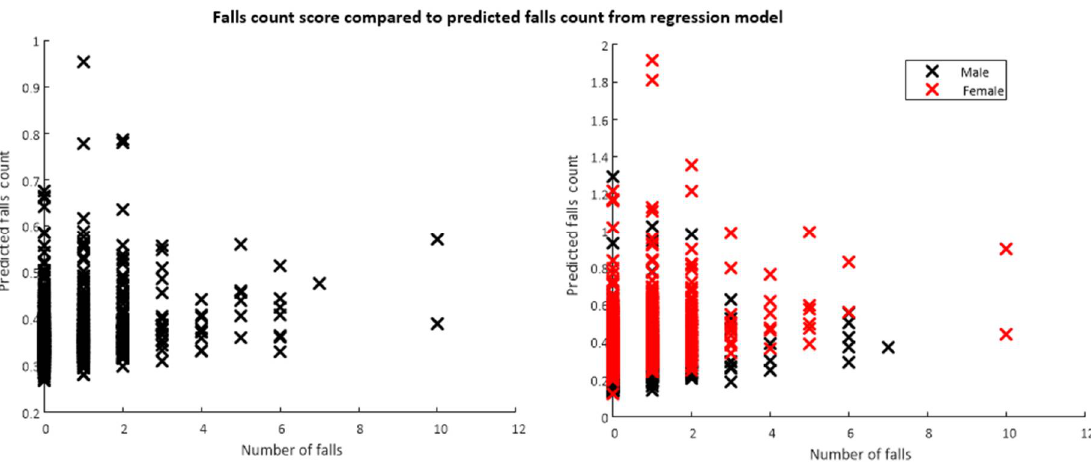
Figure A3. Poisson model fit with elastic net to TD training set data (TD-All model). Data are shown for both the all data and gender stratified (male/female) models.